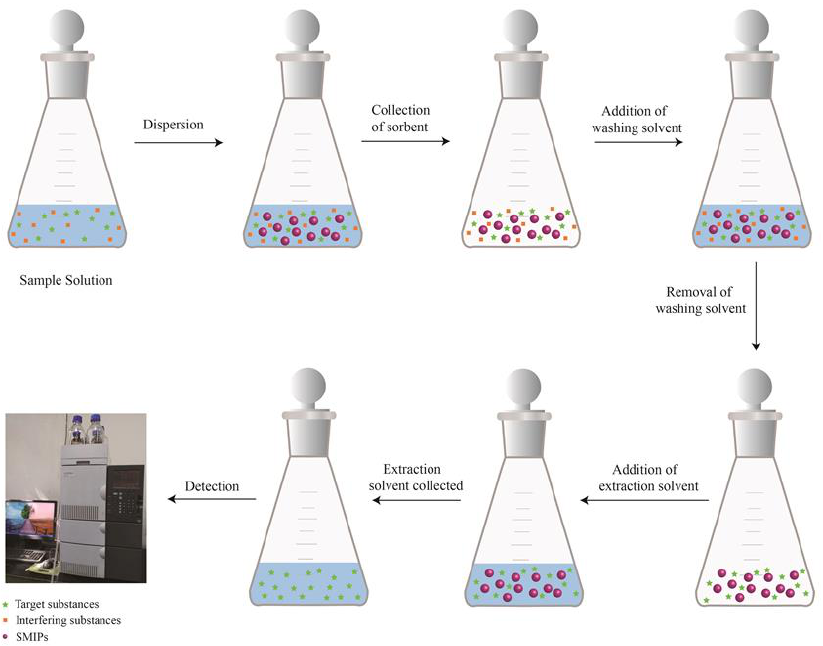
Figure 1. Graphical abstract of dispersive solid phase extraction (DSPE) method.